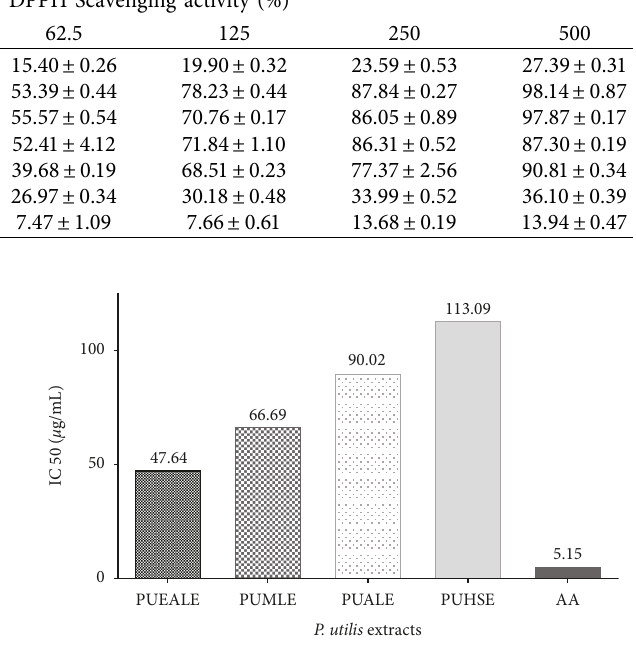
Figure 3: IC 50 values of different extracts of leaf and seed of P. utilis extracts along with ascorbic acid (AA). Table 5: DPPH inhibition percentage is shown by the standard sample ascorbic